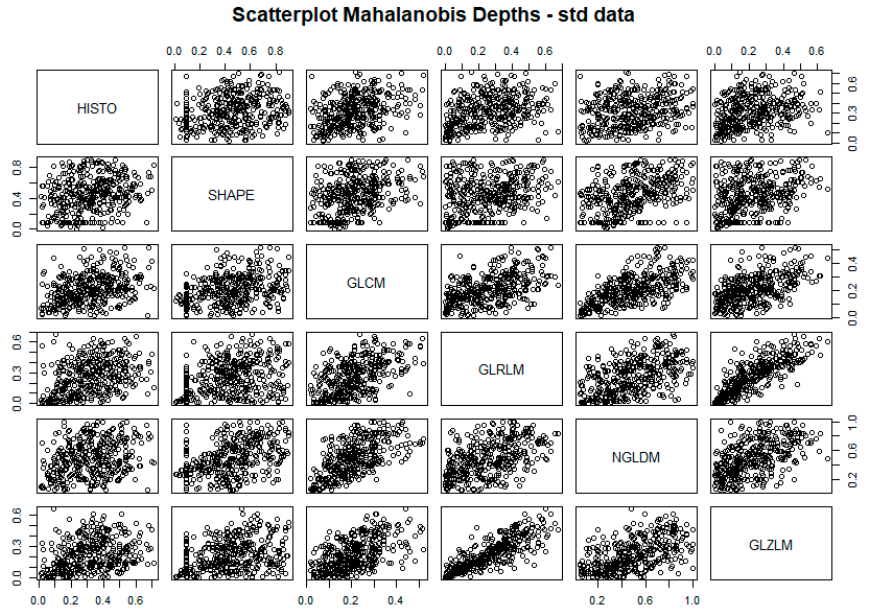
Figure 3. The pairwise scatterplots of radiomic groups’ depth measures. Correlation is low for each pair of radiomic groups but with higher values for GLZLM and GLRLM.